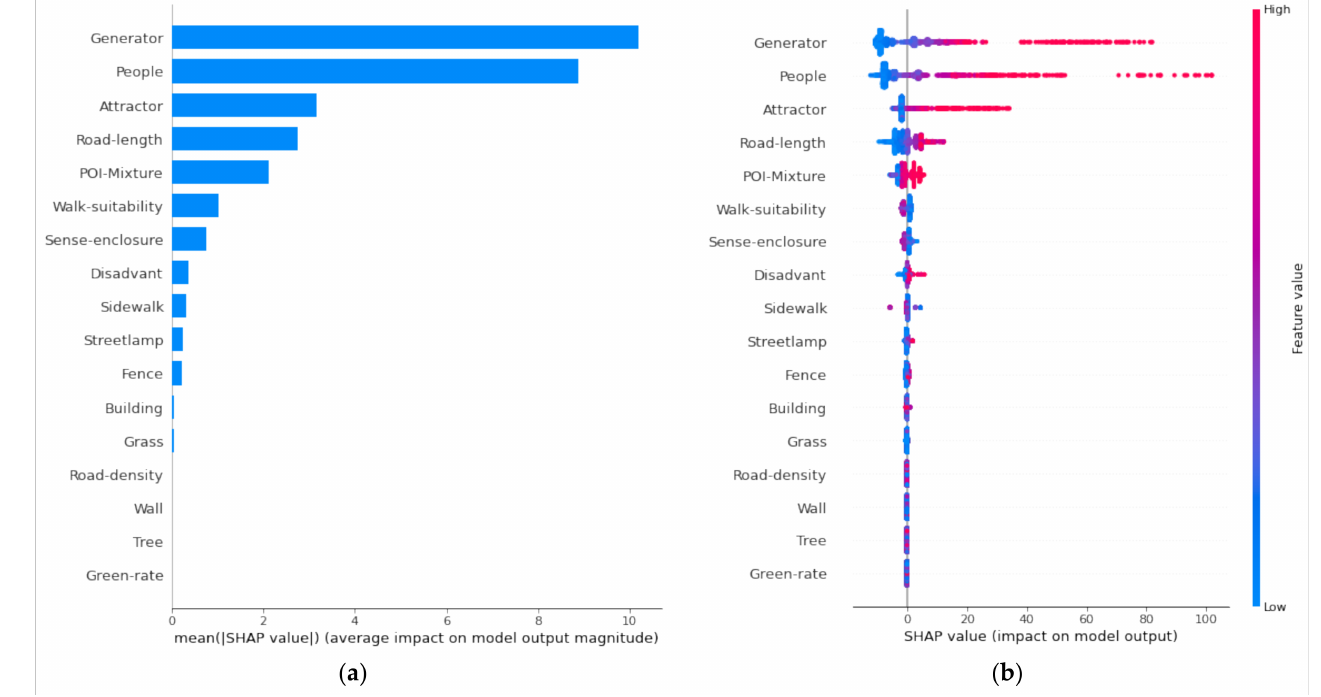
Figure 5. Interpreting the results of XGBoost using SHAP explainer at the global level. ( a ) Mean absolute SHAP values. ( b ) SHAP values of each